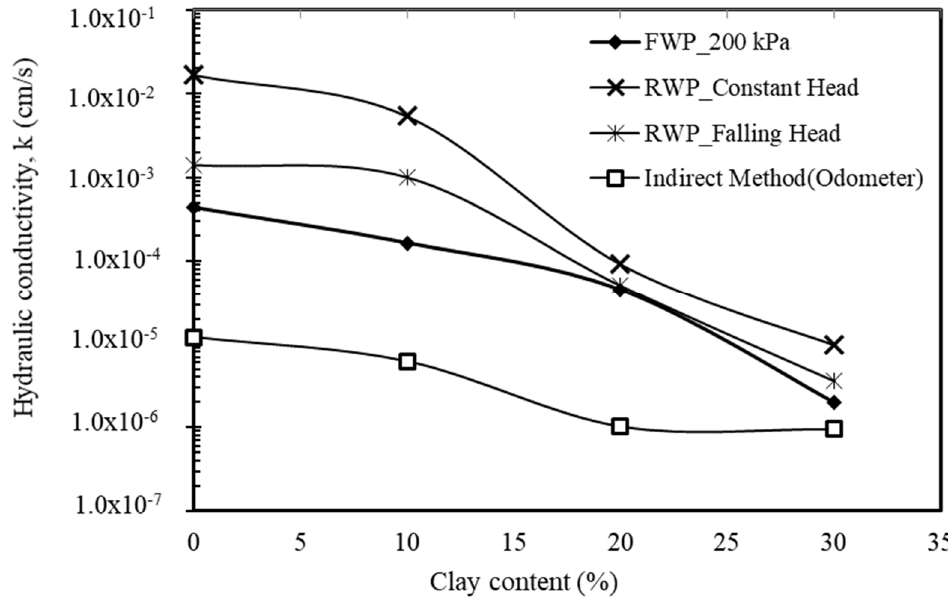
Figure 8. Hydraulic conductivity for a flexible wall at 200 kPa stress compared to other methods.